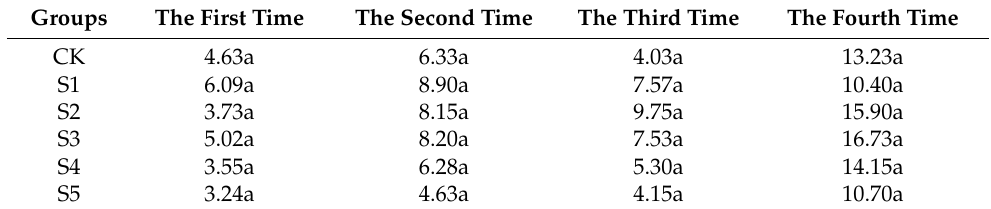
Table 4. The drain outflow during the four times’ drainage processes (L).